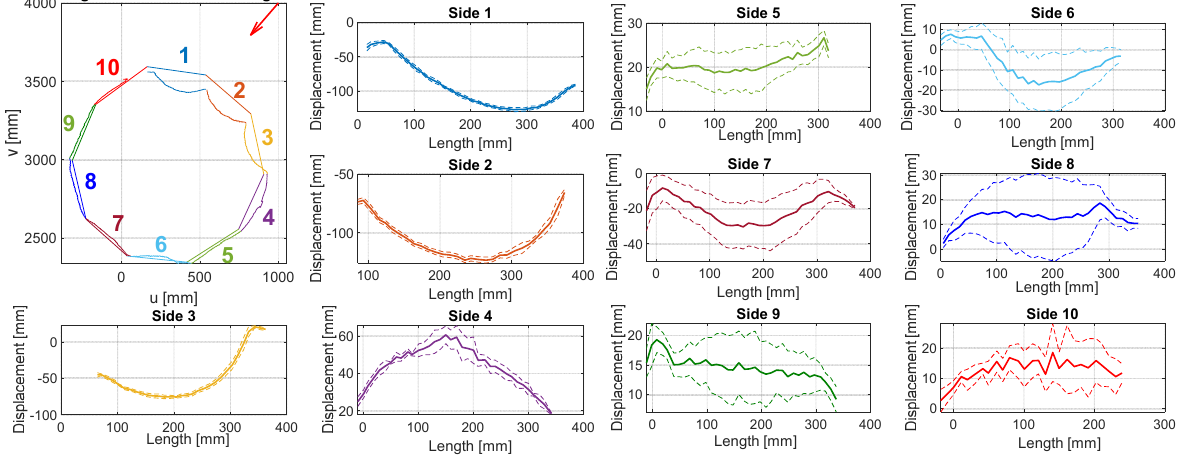
Figure 9. Example of the analysis performed for the decagonal structure of section at ½ of total height at wind speed of 176.5 km/h. The wind direction is indicated by the red arrow.